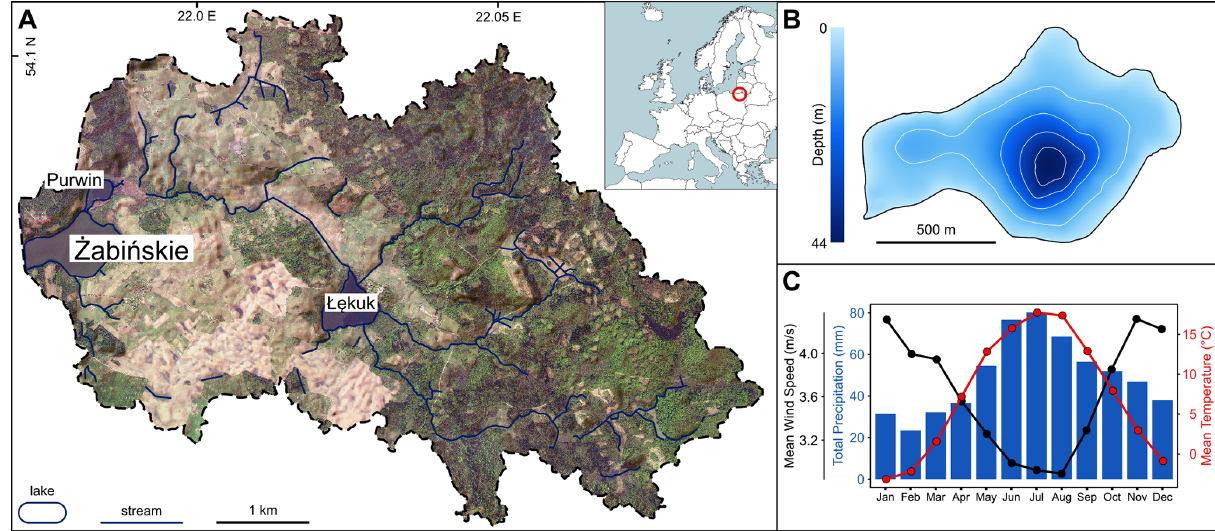
Figure 1. (a) Orthophoto map of the Lake ˙Zabi´nskie catchment (imagery from Polish Head Office of Geodesy and Cartography). Dark green colors represent forests; lighter colors represent cultivated areas. (b) Bathymetric map of Lake ˙Zabi´nskie. (c) Summary of monthly meteorological data over the period